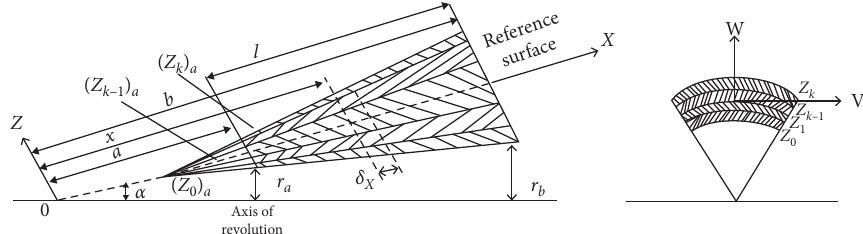
Figure 1: Layered conical shell of variable thickness: